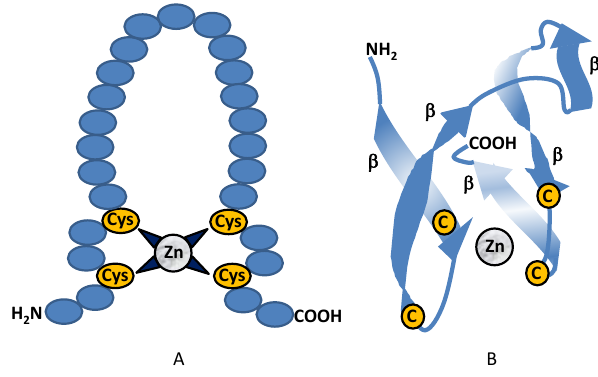
Figure 3. Primary ( A ) and secondary ( B ) structures of the C 4 domain.